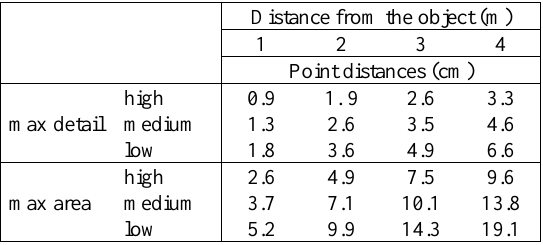
Table 3 . Vertical/horizontal distances between points acquired